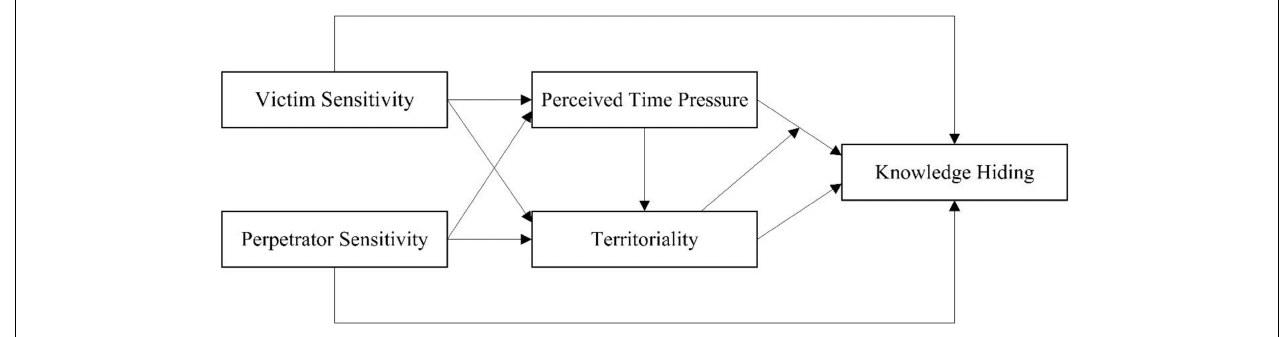
FIGURE 1 | Theoretical